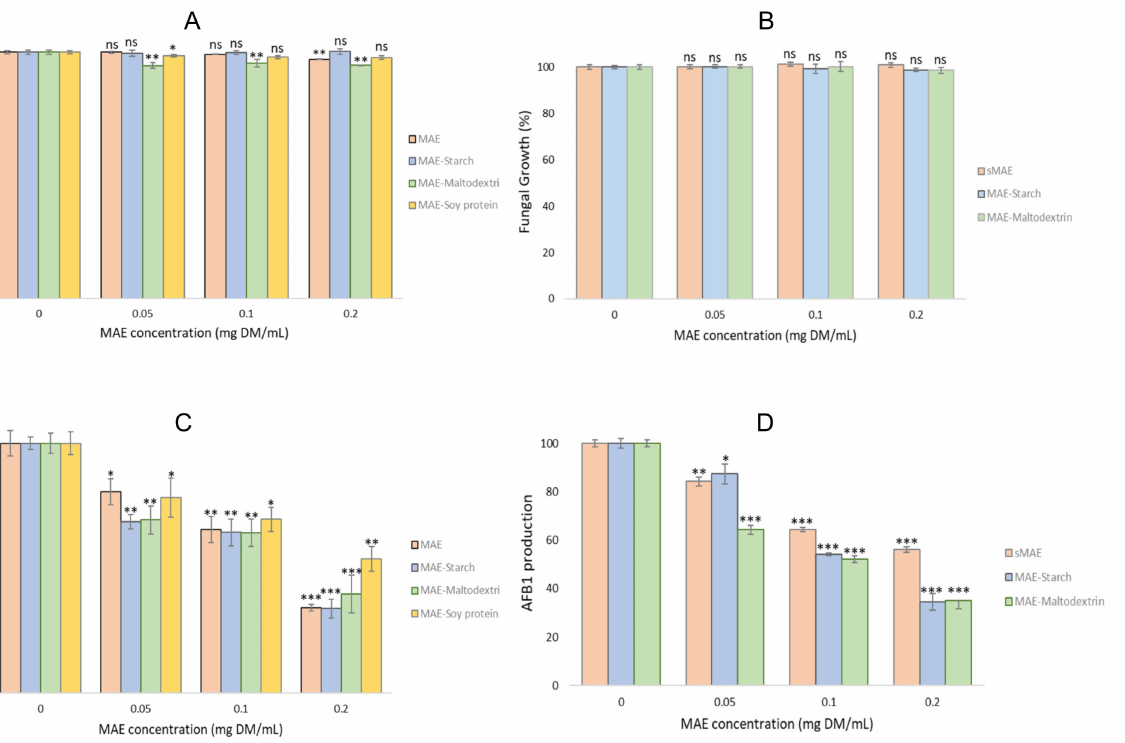
Figure 4. Fungal growth at time 0 ( A ) and after one-year storage ( B ). AFB1 production at time 0 ( C ) and after one-year storage ( D ). A. flavus NRRL 62477 strain was exposed to increasing concentrations of MAE-containing microparticles for 8 days at 27 ◦ C. MAE ( A , C ) and sMAE ( B , D ) were used as a positive control at T0 and after one year of storage, respectively. Columns with 0 correspond to A. flavus NRRL 62477 cultures with no particles nor MAE or same, and are used as control values. Results are expressed as the percentage of fungal growth or AFB1 production compared to these untreated control cultures ± standard error of the mean ( n = 4). ns = no significant change; * p- value < 0.1; ** p- value < 0.01; *** p- value <